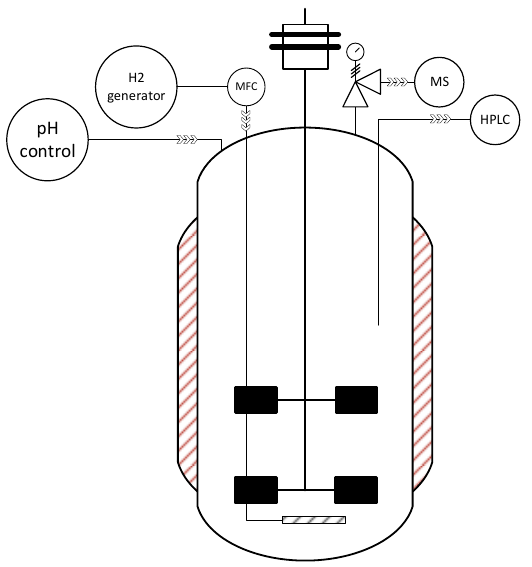
Figure 1. Bioreactor set-up for biobutanol production.